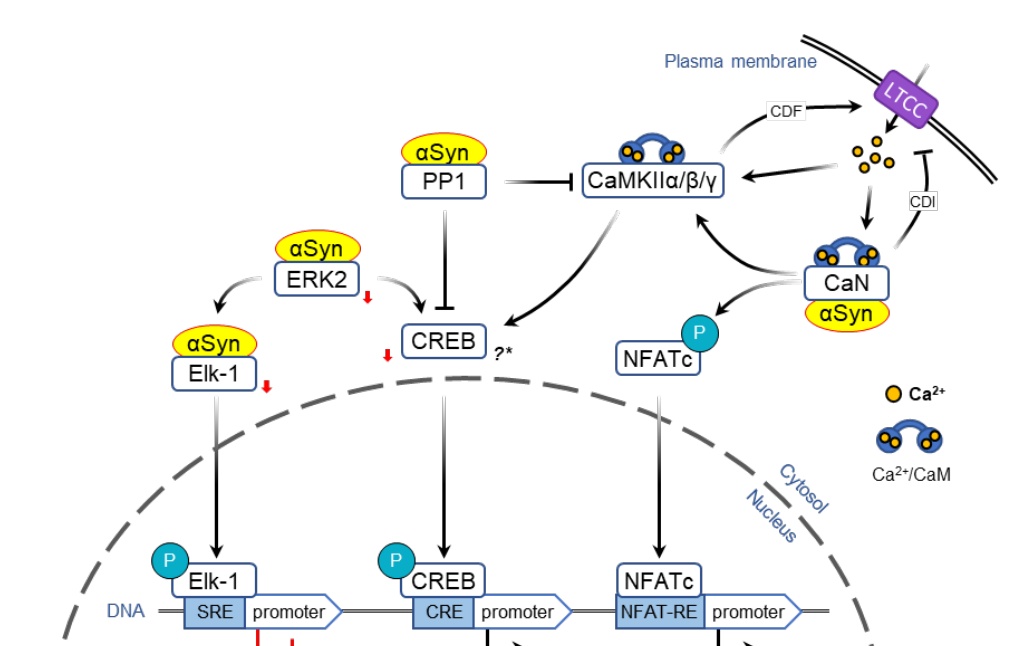
Figure 3. Role of α -Syn in regulation of immediate early gene responses. Left, Cytosolic α -Syn can interact with transcription factors involved in mitogen-activated protein kinase (MAPK) signaling such as ERK2 and Elk1, resulting in the downregulation of gene response elements. Middle, Activity-dependent pCREB activation is triggered by Ca 2+ influx through LTCC which activates calmodulin (CaM), which then binds to and activates calcineurin (CaN). Activated CaM phosphorylates CaMKII α / β , which in turn phosphorylates CaMKII γ that results in the dissociation of Ca 2+ /CaM from CaMKII γ and its translocation to the nucleus—the step that requires CaN activity. Nuclear Ca 2+ /CaM phosphorylates CREB via CaMKK and CaMKIV pathways, resulting in the binding of pCREB to its promoter on the DNA. Serine/threonine protein phosphatase 1 (PP1) inhibits this cascade by dephosphorylating pCREB and CaMKII α / β . Right, Activated CaN dephosphorylates NFATc, exposing its nuclear localization sequences (NLS) and facilitating its translocation to the nucleus, where it binds to promoter DNA to control transcription. Binding of α -Syn to Ca 2+ /CaM/CaN complex and PP1 may affect the induction of NFATc and pCREB factors as well as the gating properties of LTCC by interfering with Ca 2+ -dependent facilitation (CDF) or inactivation (CDI). *—The effect of α -Syn expression on pCREB induction has not been investigated to